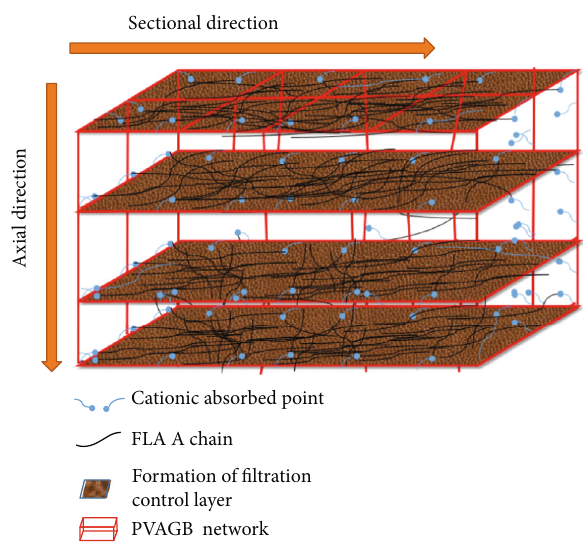
Figure 1: Schematic c. Note: the rearrangement of FLA A chain distribution was formed by absorption mechanism and the adjustment of the chain distribution by a spatially fi xed and cross- linked network of the PVAGB polymer. Sectional direction was de fi ned for the formation of fi ltration control multilayers. The direction was vertical to the fl owing direction of cement slurry; free water was blocked on a certain layer to keep the perfect ratio of cement to water resulting in better hydration of cementitious material; axial direction was de fi ned for the formation of fi ltration control multilayers. The direction was along the fl owing direction of cement slurry. And free water possibly fl owed along the axial direction micropore within the cement-based material, and the hydration process of the material was partly delayed or stopped due to lack of free